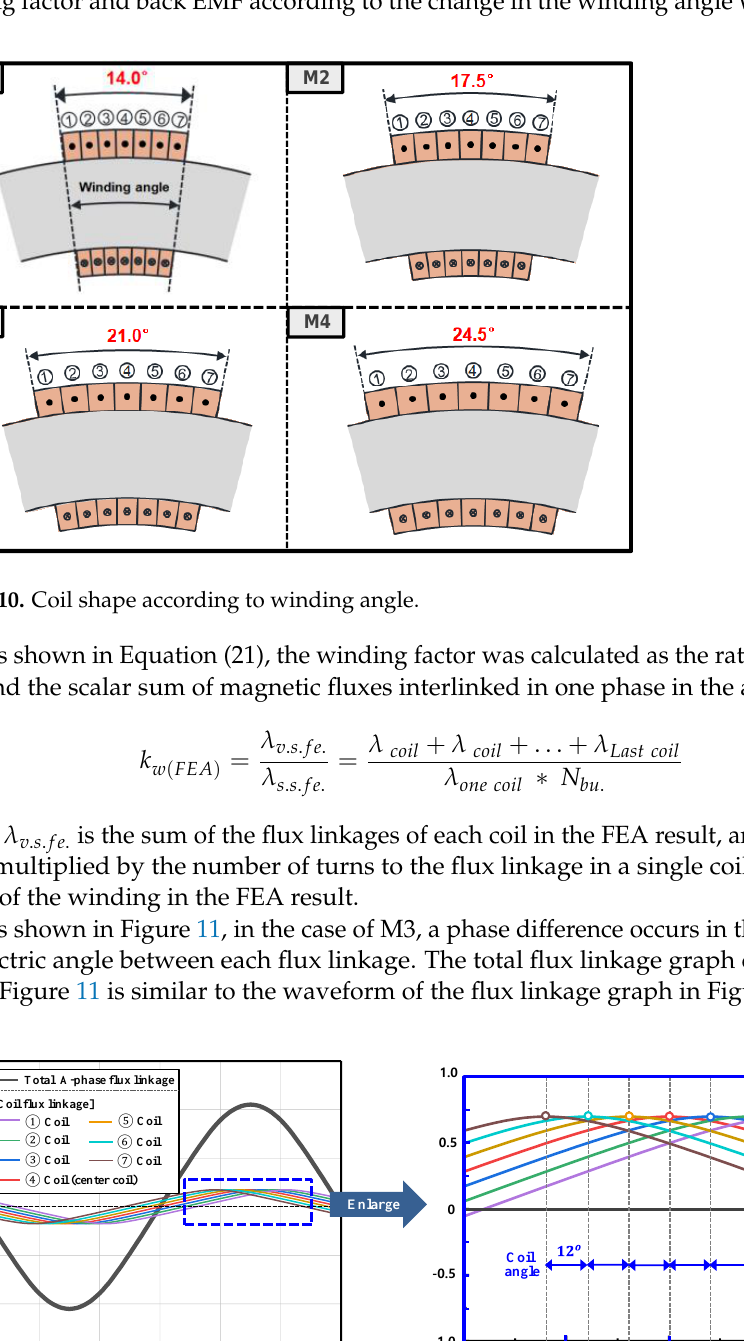
As shown in Figure 12, the air-gap magnetic flux density and winding factor according